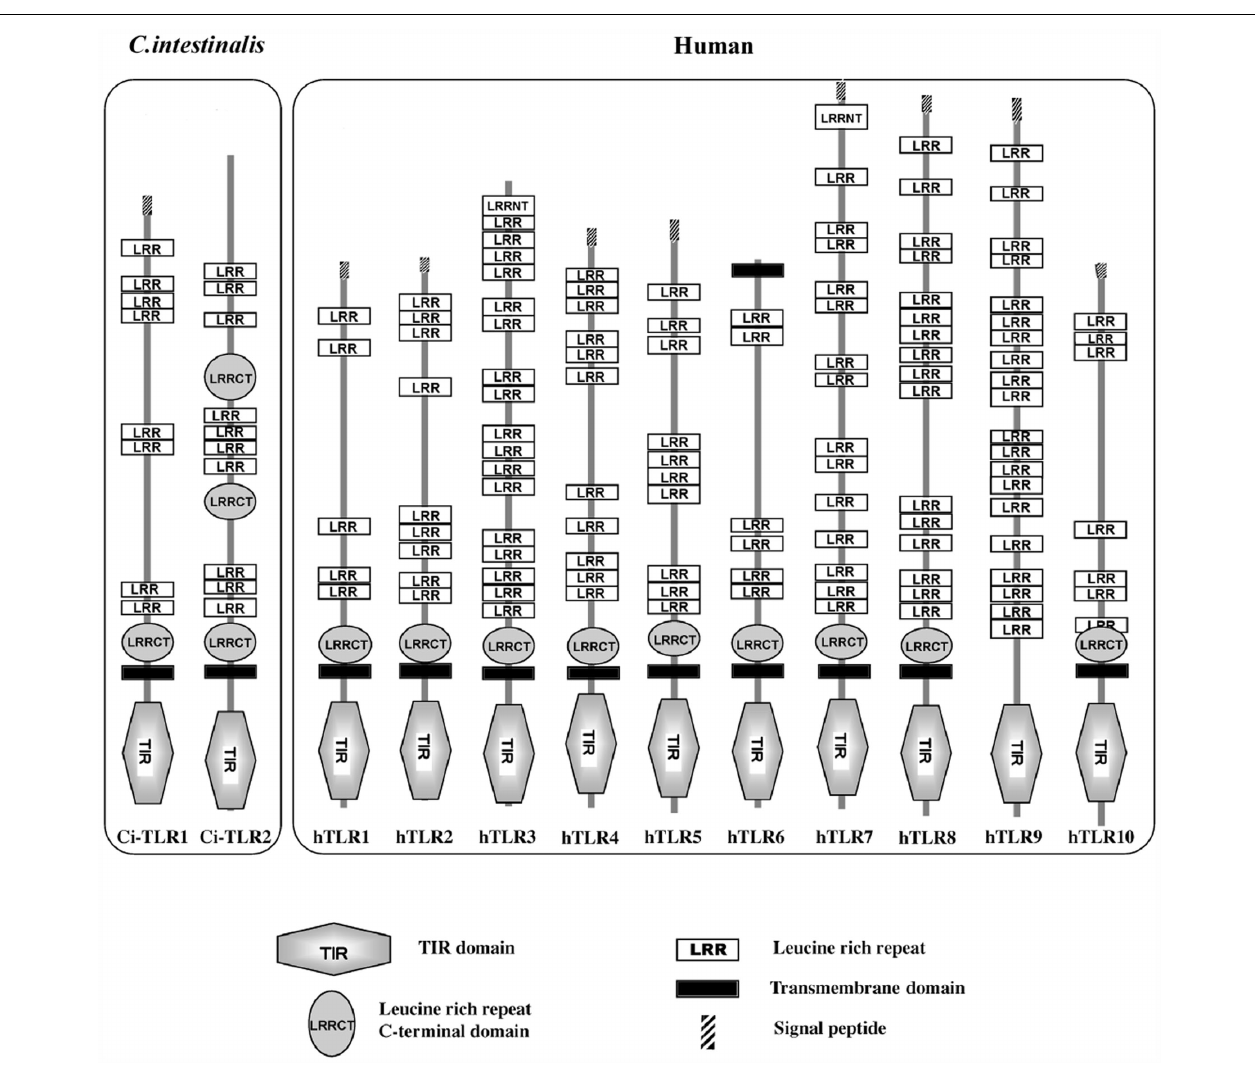
FIGURE 1 | Structural organization of Ciona TLRs (Ci-TLR ) and humanTLRs (hTLR).